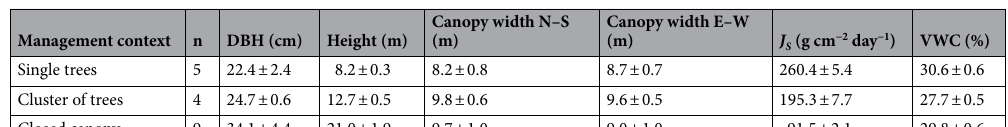
Table 1. Characteristics of study trees, including tree size, canopy width north–south (N–S) and east–west (E–W), daily sum of sap flux ( J S ), and daily volumetric water content (VWC). Values are mean ±